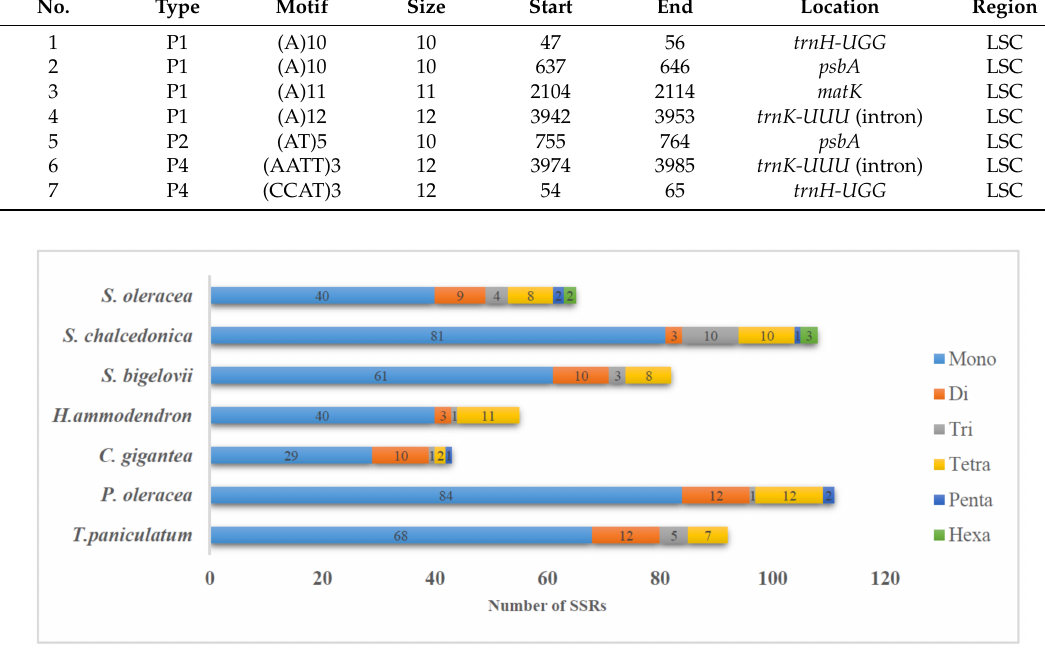
Table 7. Simple sequence repeats in the CDSs of the T. paniculatum chloroplast genome. No.